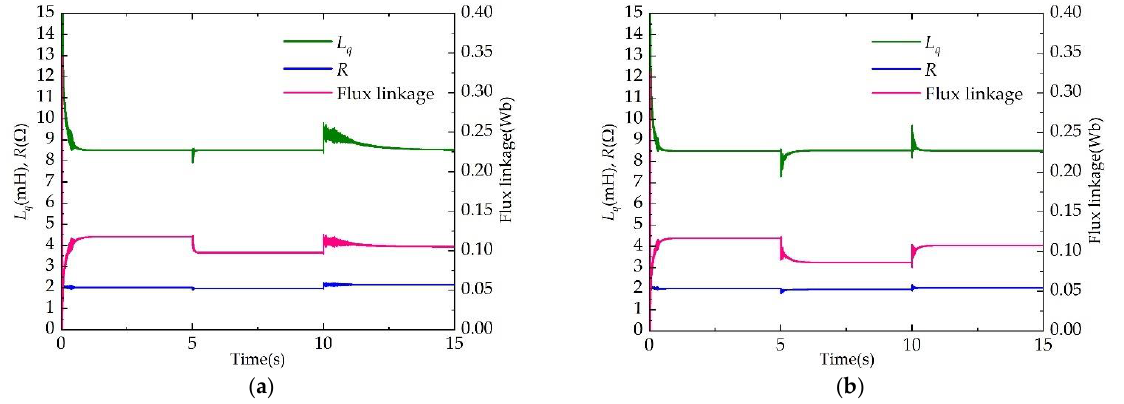
Figure 19. Parameter identification results: ( a ) Results of PMSM parameters identification during speed change; ( b ) Results of PMSM parameters identification during load change.